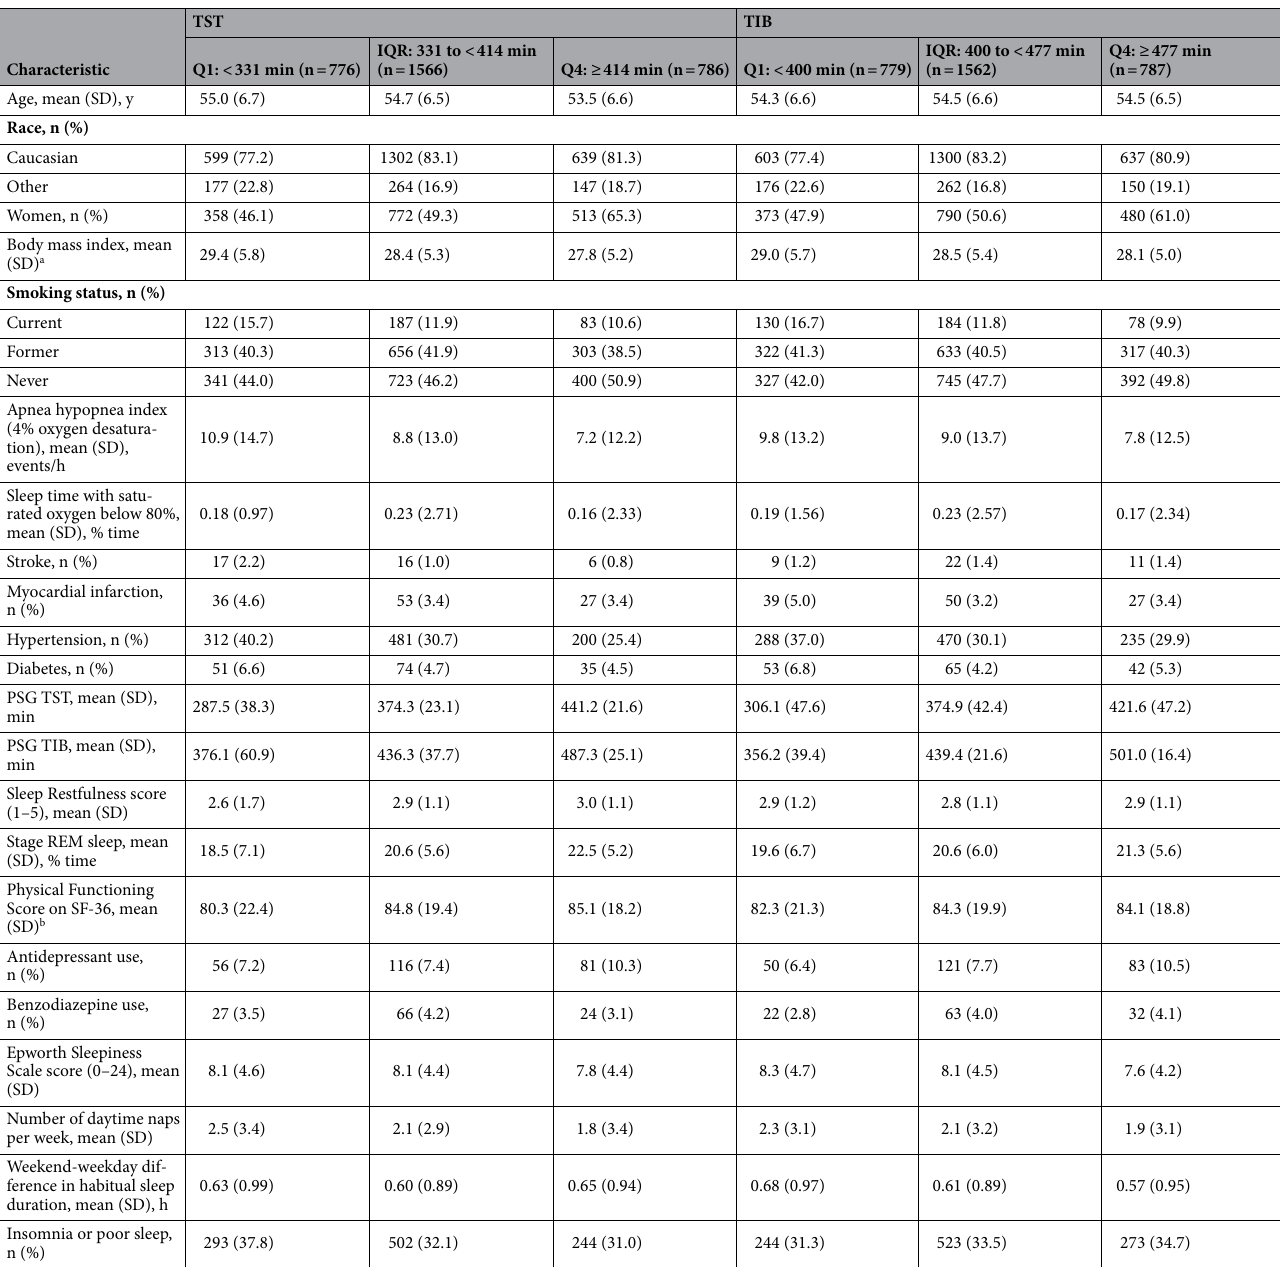
Table 1. Baseline demographic, health, and sleep characteristics of middle-aged adults by TST quartile or TIB quartile (n = 3128). SD standard deviation, PSG polysomnography, TST total sleep time, TIB time in bed, REM rapid eye movement. a Body mass index is calculated as weight in kilograms divided by height in meters squared. b SF-36, Short Form 36 Health